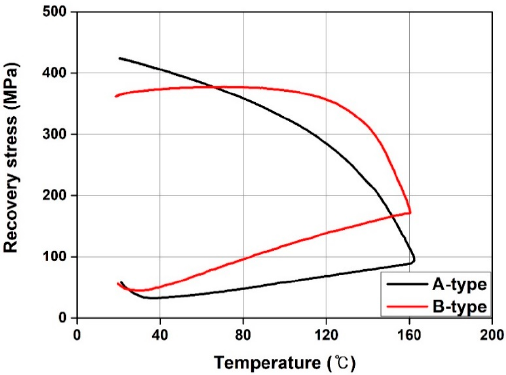
Figure 2. Recovery stress–temperature curves according to type of Fe-SMA at prestrain 0.04, heating temperature 160 ℃ [12].